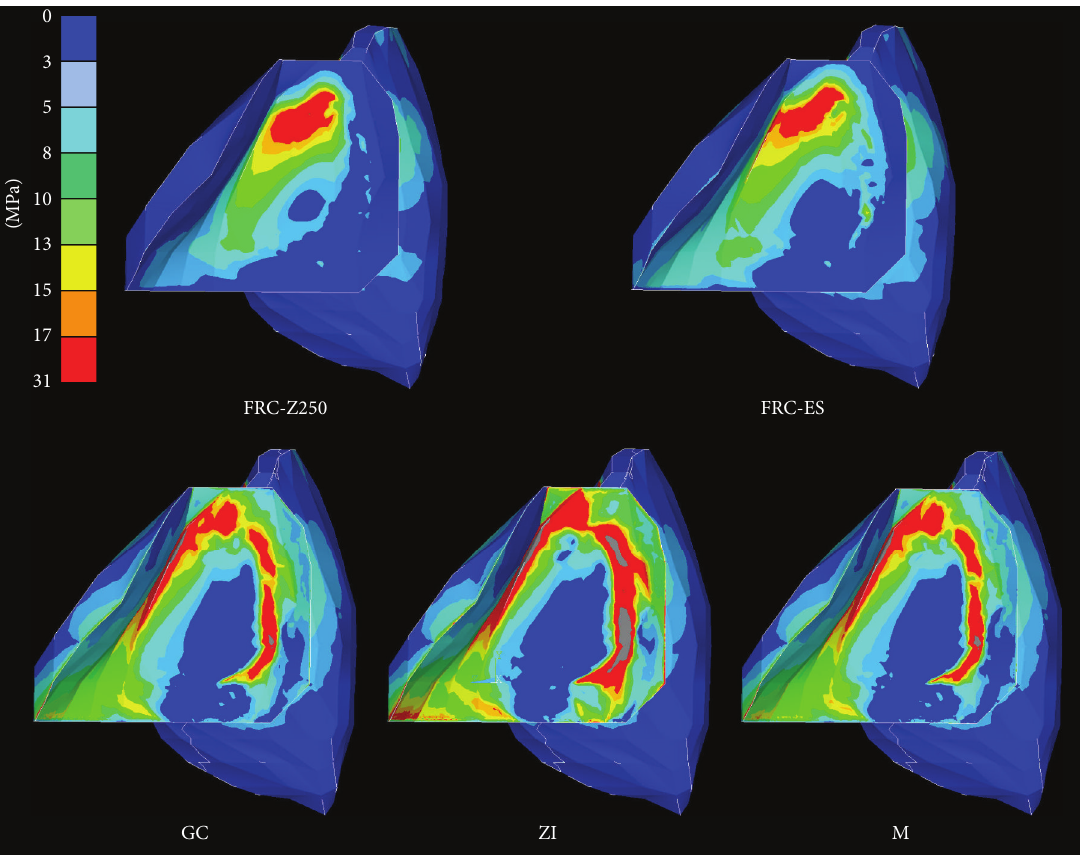
Figure 5: Principal stress distribution at the cement-retainer interface for two-unit cantilever RBFDPs of various framework materials. Table 2: Maximum and minimum principal stress (MPa) and displacement (mm) for two-unit cantilever RBFDPs of various framework materials. FDP Cement-retainer interface Cement layer Abutment tooth Max. Min. Disp. Max. Min. Disp. Max. Min. Disp. Max. Min.